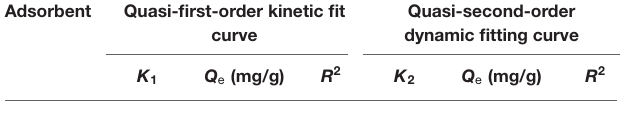
FIGURE 8 | Adsorption kinetics of MIP1 on ACT.